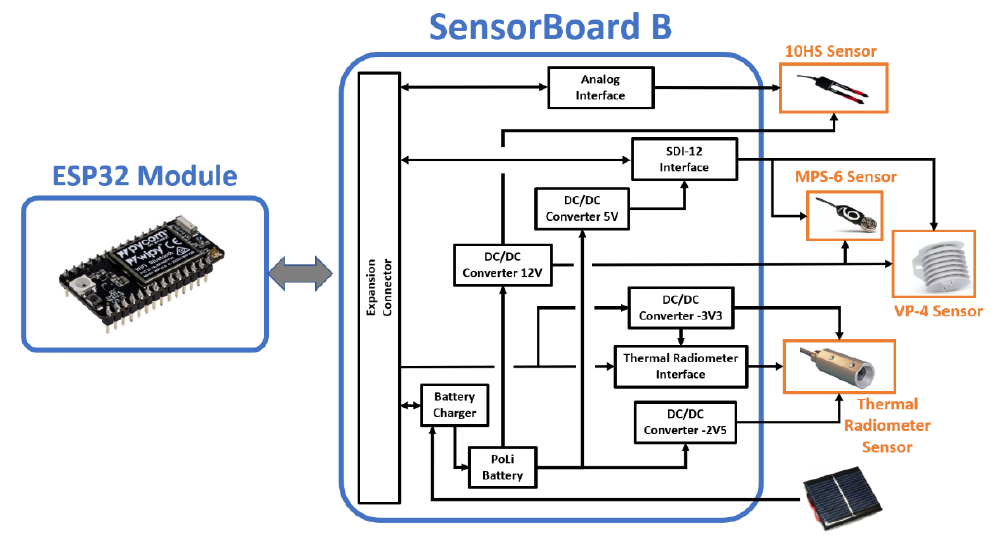
Figure 4. Block diagram of type-B node.